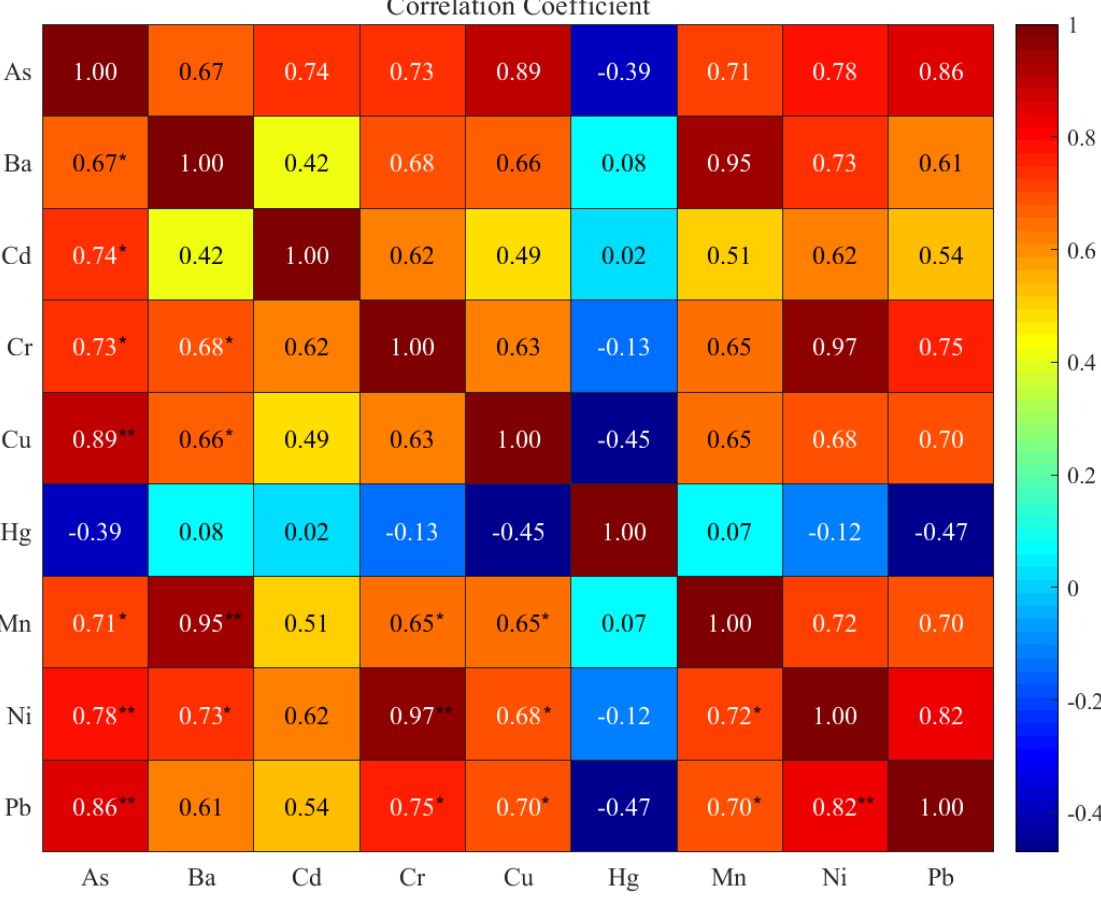
Figure 3. Pearson correlation analysis of heavy metals in the whole body of crayfish. The correlation coefficient is illustrated by the intensity of the colors, as shown by the color scale (Notes: *: p < 0.05, **: p < 0.01).